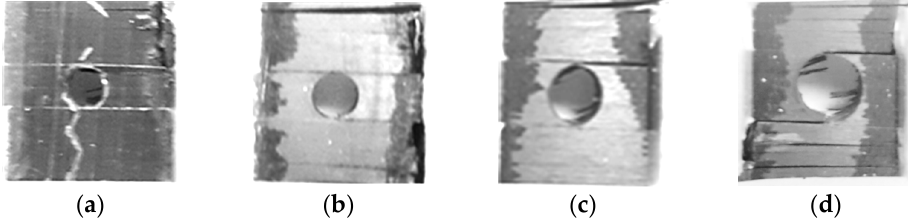
Figure 18. Stress vs. displacement in the compression mode, in the presence of various holes; ( a ) complete curves; ( b ) expanded regions where local load relaxation is observed.